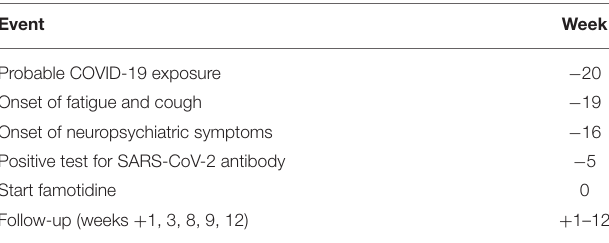
TABLE 1 | Timeline of clinical case history, time is referenced to the initiation of treatment with famotidine (week =